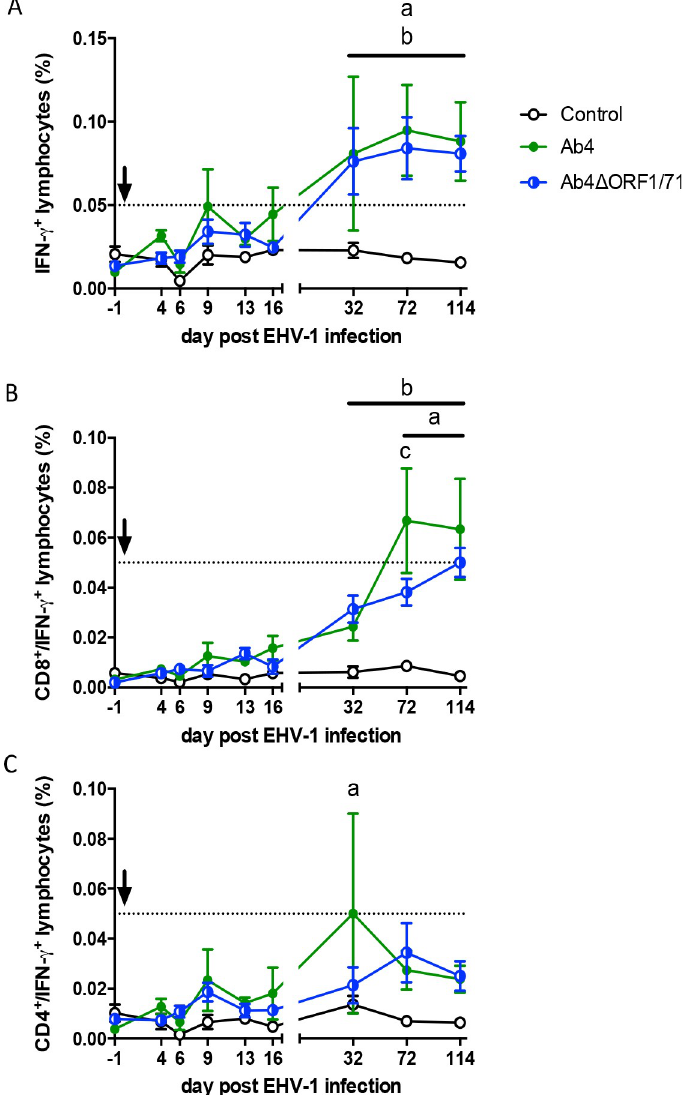
Fig 5. EHV-1 specific IFN- γ producing lymphocytes in PBMC. EHV-1 na ï ve horses (n = 5 per group) were infected with the EHV-1 strain Ab4 or the deletion mutant virus Ab4 Δ ORF1/71. Non-infected horses were kept as controls. The arrow marks the time of infection. PBMC were isolated at different times post infection and re-stimulated with EHV-1 strain Ab4 ex vivo or were kept in cell culture medium for control. The secretion inhibitor Brefeldin A was added to the cultures for the last 24 hours. Cells were harvested at 48 hours, fixed, stained for intracellular IFN- γ production and cell surface CD4 and CD8, and measured by flow cytometry. The analyzing gate was set on small lymphocytes. Mean and standard errors for the percentages of (A) total IFN- γ + lymphocytes, (B) CD8 + /IFN- γ + lymphocytes, and (C) CD4 + /IFN- γ + lymphocytes are displayed over time. All percentages for IFN- γ + cells were corrected by the respective medium control values. The dotted horizontal line represents a suggested cutoff of 0.05% IFN- γ + lymphocytes. Values below this cutoff were typically reached for IFN- γ + cells in the non-infected control group prior to correction by medium control values. Significant differences between groups are marked: a = Ab4 vs. controls, b = Ab4 Δ ORF1/71 vs. controls, and c = Ab4 vs. Ab4 Δ